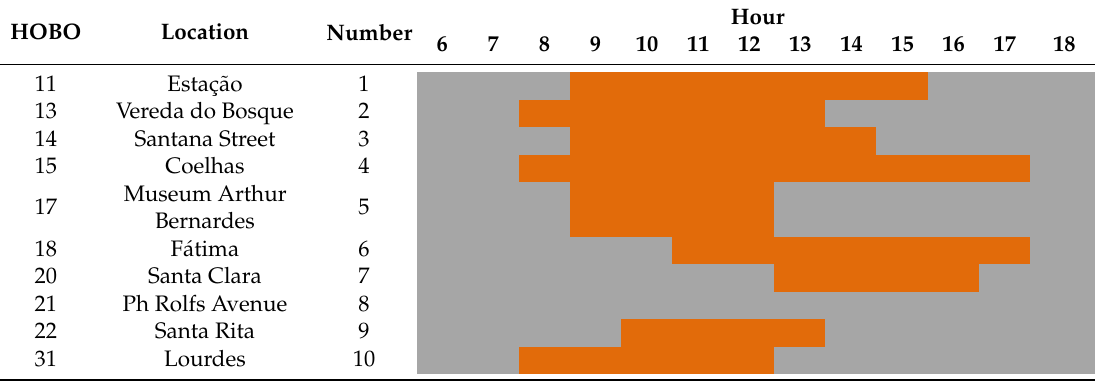
Table 2. Sky view factor (SVF) of collection points in the municipality of Viçosa-MG. Location Point SVF